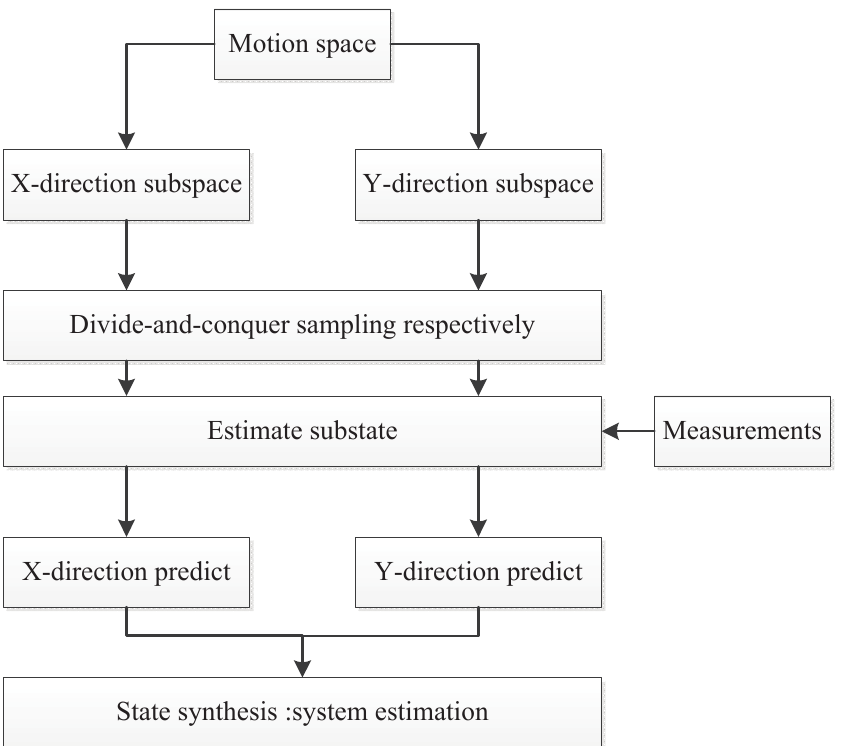
Figure 1. The flowchart of spatial divide-and-conquer sampling